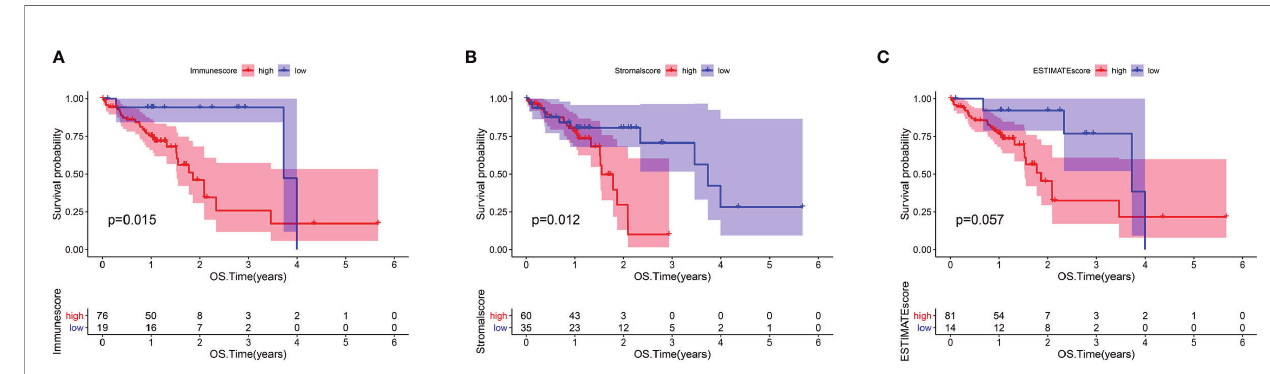
FIGURE 2 | Immune and Stromal scores were correlated with overall survival of ESCC. (A) Kaplan – Meier survival analysis for ESCC patients grouped into high or low score in Immunescore determined by the optimal cutoff. p = 0.015 by log-rank test. (B) Kaplan – Meier survival curve for Stromalscore with p = 0.012 by log-rank test. (C) Survival analysis with Kaplan – Meier method for ESCC patients grouped by ESTIMATEScore (p = 0.057 by